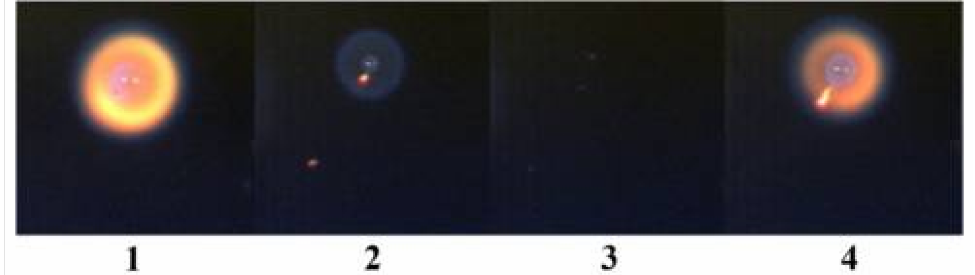
Figure 2. Extinction of the droplet (frames 1 and 2), flameless combustion of the droplet (frame 3), and repeated flash of the flame of the droplet (frame 4) under microgravity conditions.